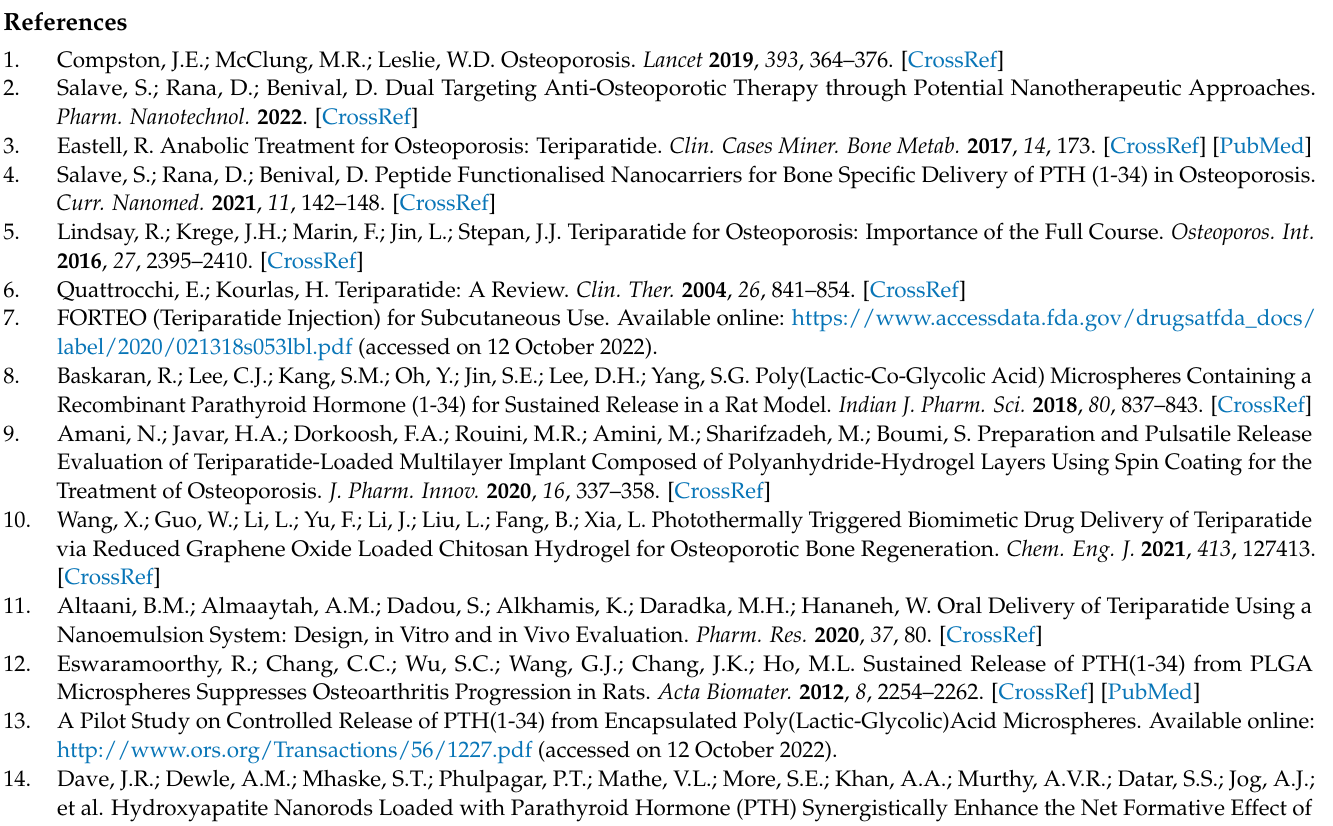
diagram; Figure S3. Residual analysis for particle size. (A) Normal plot of residuals, (B) Residual versus Predicted plot, (C) Predicted versus actual plot, (D) Residual versus run plot; Figure S4. Residual analysis for %EE. (A) Normal plot of residuals, (B) Residual versus Predicted plot, (C) Predicted versus actual plot, (D) Residual versus run plot; Figure S5. Counter plot. (A,B) for the particle size, (C,D) for %EE; Figure S6. Box plot for particle size; Figure S7. Box plot for %EE; Figure S8. Design space for PTH-LPs; Table S1. Layout of experimental design; Table S2. Statistical data of model